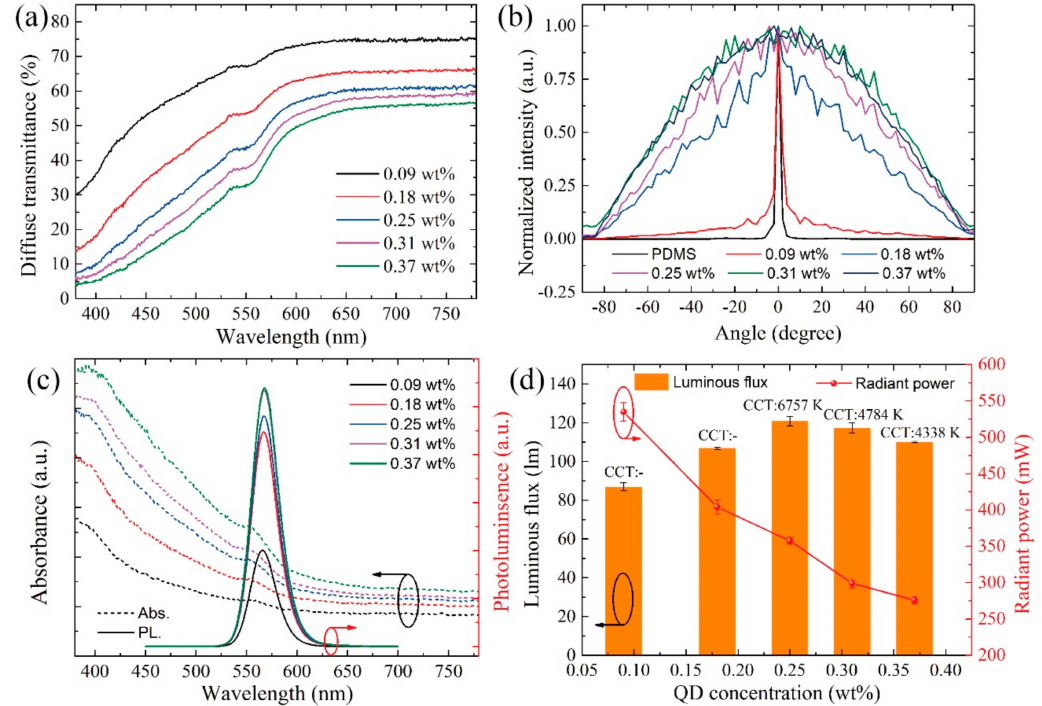
Figure 3. Optical properties of CPF films corresponding to various concentrations that varies from 0.09 to 0.37 wt%. ( a ) Diffuse transmittance. ( b ) BTDF. ( c ) Absorbance and PL. ( d ) Luminous flux and radiant power of LED devices with CPF